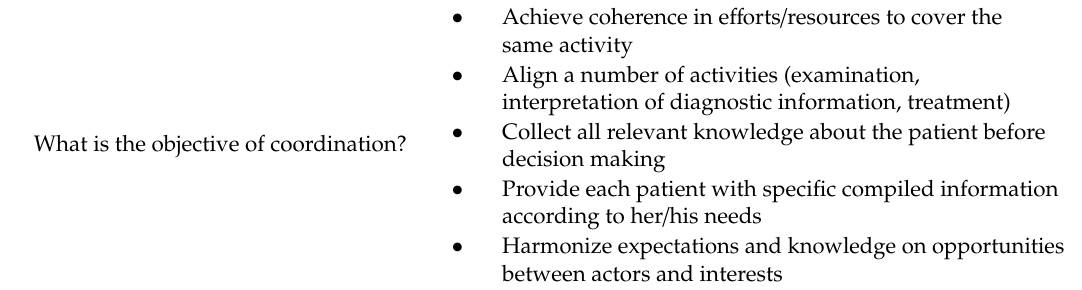
Table 4. Coordination activities in patient